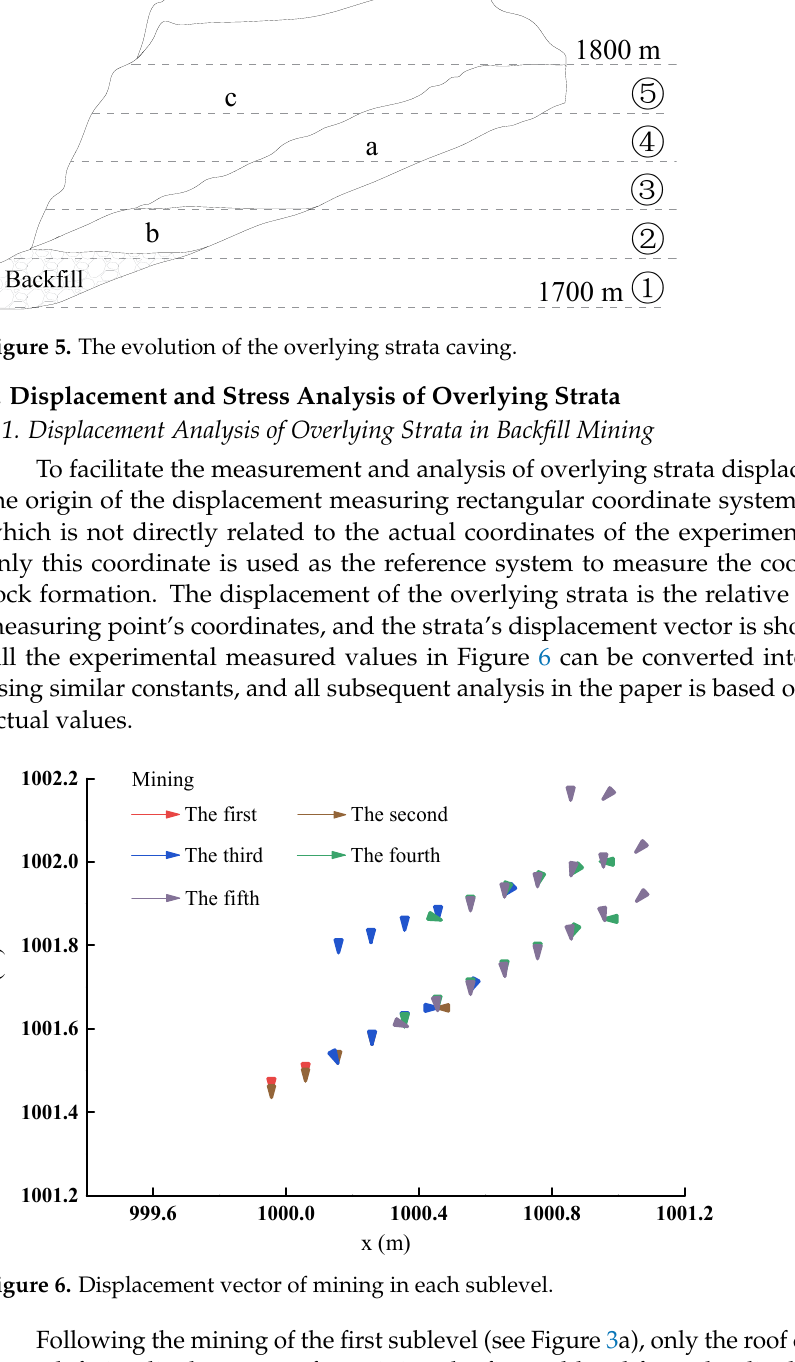
Figure 4. Excavation process of backfill mass: ( a ) Backfill mass excavation to the third sublevel; ( b ) Backfill mass excavation to the second sublevel; ( c ) Overlying strata caving; ( d ) Overlying strata continuous caving.